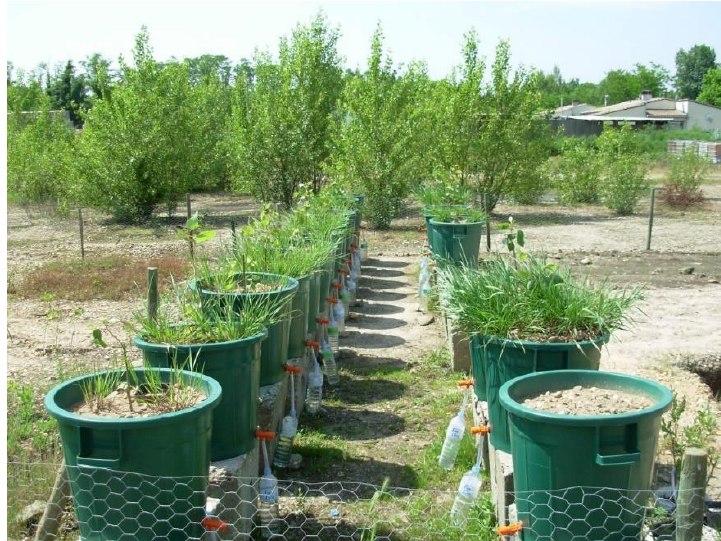
Figure 1. Lysimeters filled with untreated and phytomanaged soils.